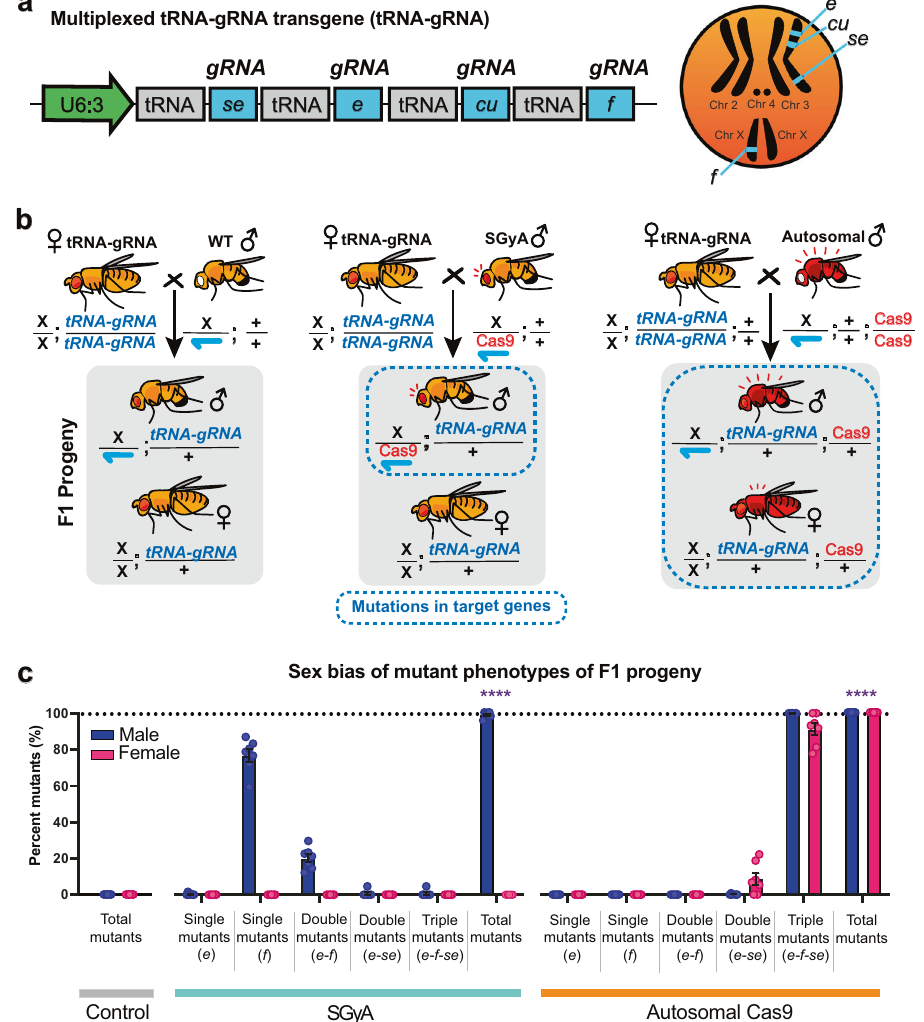
Fig. 2 Functionality of the SGyA with a multiplexed tRNA-gRNA system. a The multiplexed tRNA-gRNA transgene was used to determine the functional capacity of a Y-linked Cas9 to cleave four phenotypic genes, sepia (se) , ebony (e) , curled (cu) , and forked (f) . Flanking the gRNA ’ s with tRNAs enables expression from a single promoter and processing of the multiplexed gRNAs. Karyotype on the right depicts the location of the four target sites. No cu mutants were obtained and were thus omitted. b Crossing schematic of experiment. Homozygous tRNA-gRNA females were outcrossed to either WT, SGyA, or autosomal Cas9 males. F1 progeny were expected to have either no phenotype and/or a range of mutant phenotypes. Those expected to have a phenotype are indicated in blue dashed borders. c Percentages of F1 progenies with single mutations, double mutations, or triple mutations. F1 progeny from genetic crosses involving SGyA demonstrated single, double, and triple mutants with only 38% of the progeny being composed of f mutants. Crosses involving an autosomal source of Cas9 produced mainly triple mutants. For experimental crosses, seven replicate crosses were set up. For the control, only fi ve replicate crosses were set up. A two-way ANOVA with Tukey ’ s multiple comparisons was performed on the total mutants (both male and female) comparing wild type and SGyA or autosomal Cas9 data to determine signi fi cance. Error bars in black represent the mean ±SEM. **** p < 0.0001. Source data is provided as a Source Data fi